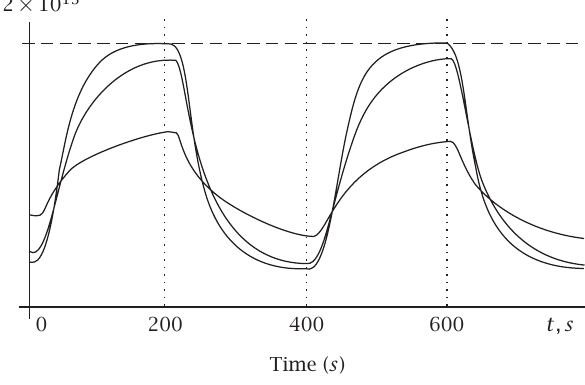
Figure 2.2 . Influence of capturing and releasing the gas by